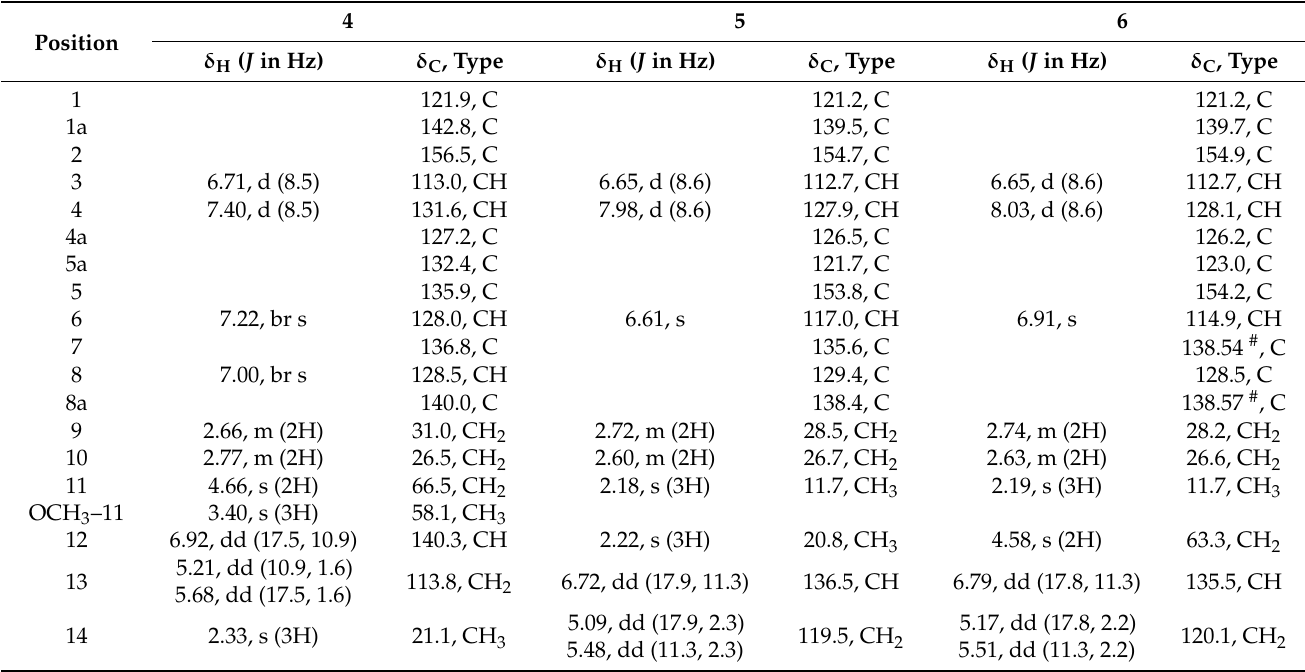
Table 2. 1 H (500 MHz) and 13 C (125 MHz) NMR data of compounds 4 – 6 (in methanol- d 4